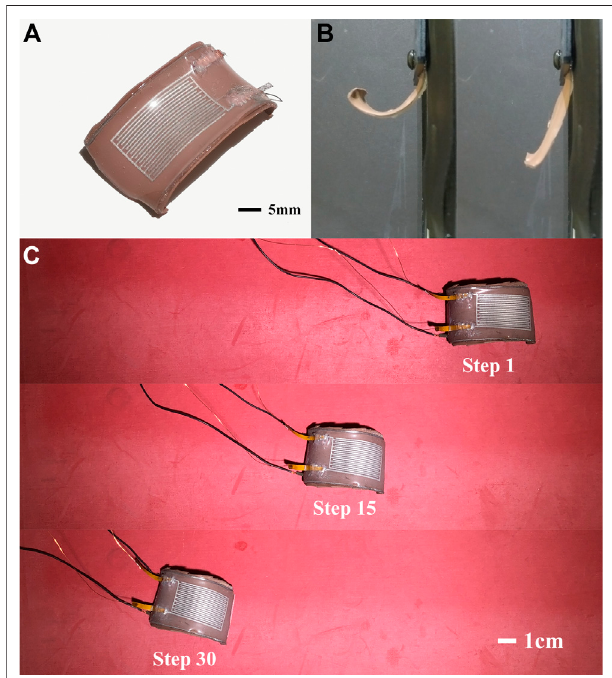
FIGURE 1 | (A) Sensorized SMA actuator composed of thermally conductive elastomers, U-shaped SMA wire and LM strain gauge. (B) The relaxed (left) and activated (right) state of the actuator. (C) Locomotion of single actuator with closed-loop control using sensor feedback.